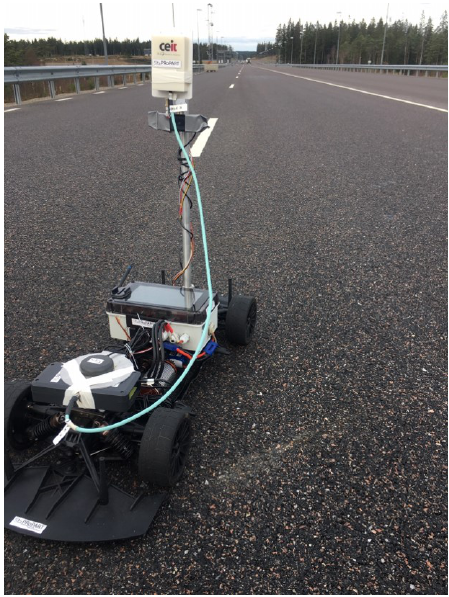
Figure 10. UWB mobile node attached to the RC